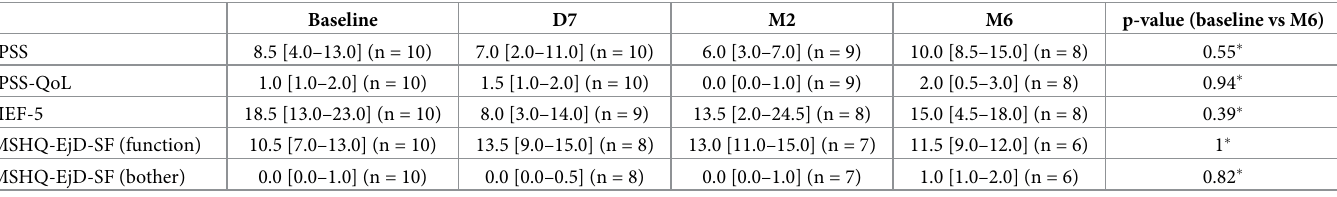
Table 4. Shows the median scores [IQR] of IPSS, IIEF-5 and MSHQ-EjD-SF at baseline and at 7 days, 2 months and 6 months of